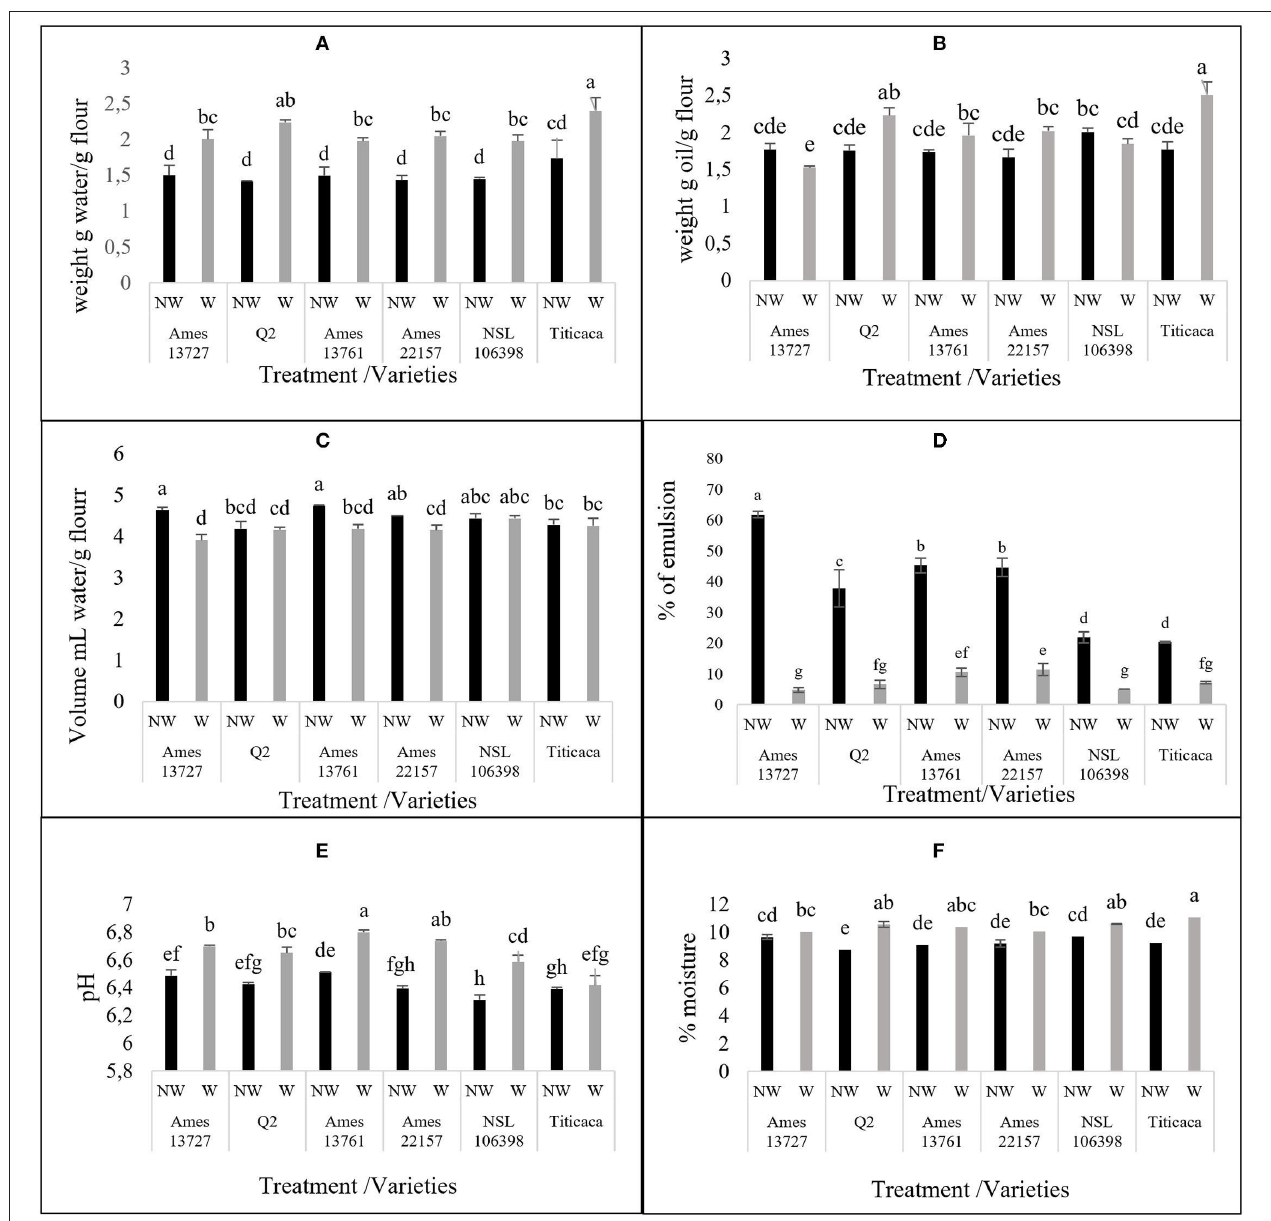
FIGURE 4 | The effect of wet method in techno-functional (A) water holding capacity, (B) oil holding capacity, (C) Swelling capacity, (D) Emulsifying activity and physico-chemical (E) pH, (F) Moisture % properties of different quinoa seed genotypes. NW, non-washed seeds; W, washed seeds.